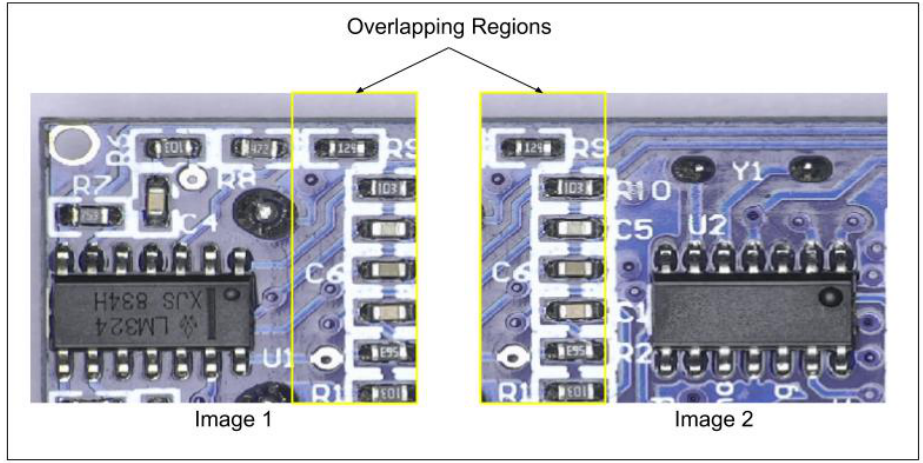
Figure 2. Example for the image stitching problem, where the two yellow areas represent the overlap to be found.